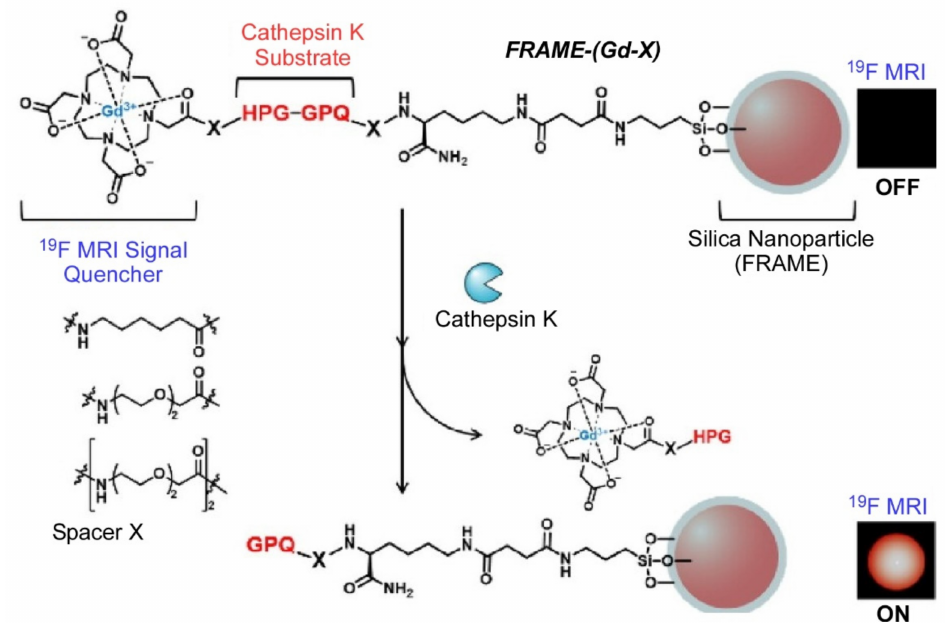
Figure 5. A novel 19 F-MRI probe, FLAME-(Gd-X), for the detection of Cathepsin K. The 19 F-NMR signal intensity of these probes is suppressed by paramagnetic relaxation due to the Gd 3+ complex, but signal intensity increases specifically upon cleavage of the substrate by Cathepsin K. Reprinted with permission from [132]. Copyright 2021, Chemical Society of